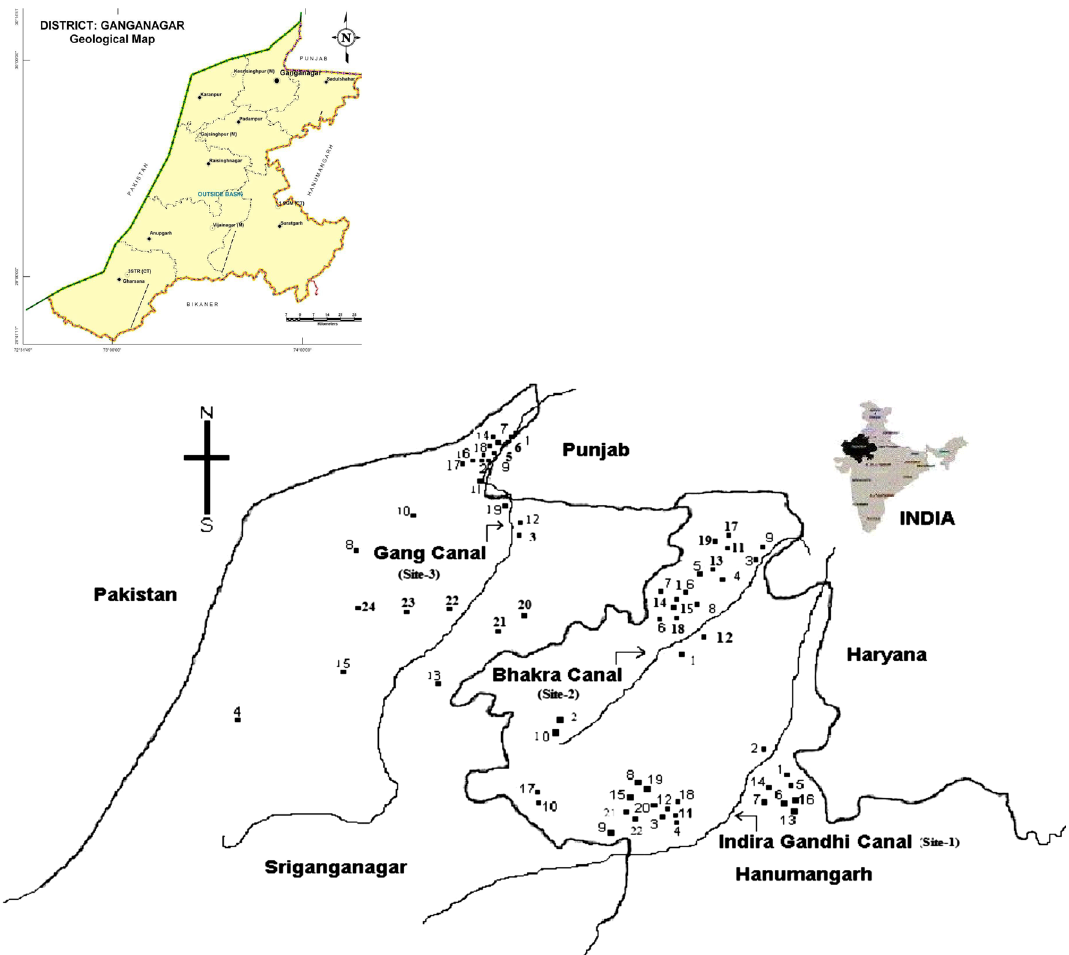
Fig. 1 Location of groundwater sampling in three different